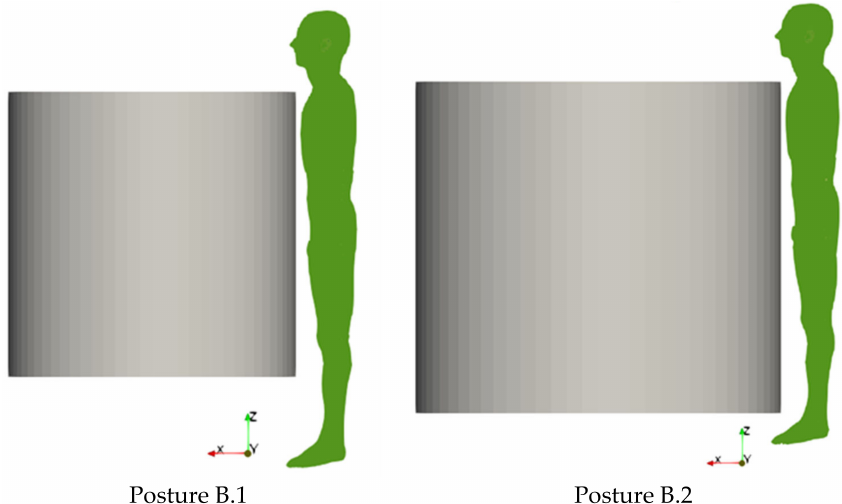
Figure 2. Two considered positions of the human body with reference to the exposure scenario B. On the left the case of 220 kV line trap coil (B.1), on the right the case of the 380 kV line trap coil